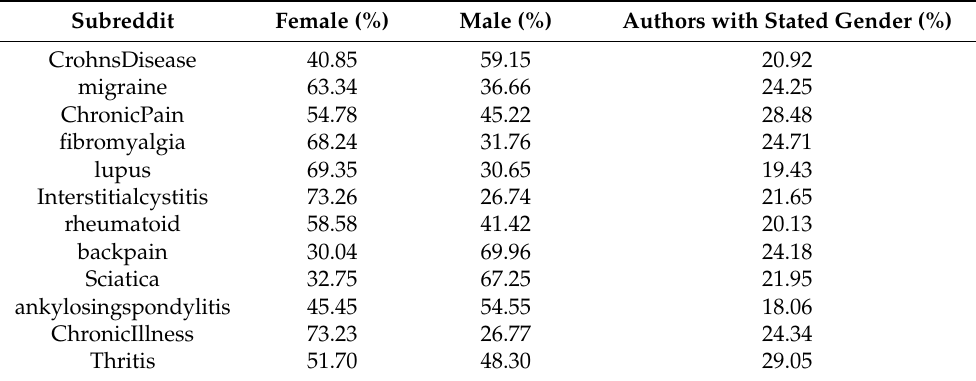
Table 2. Binary gender distribution per subreddit.